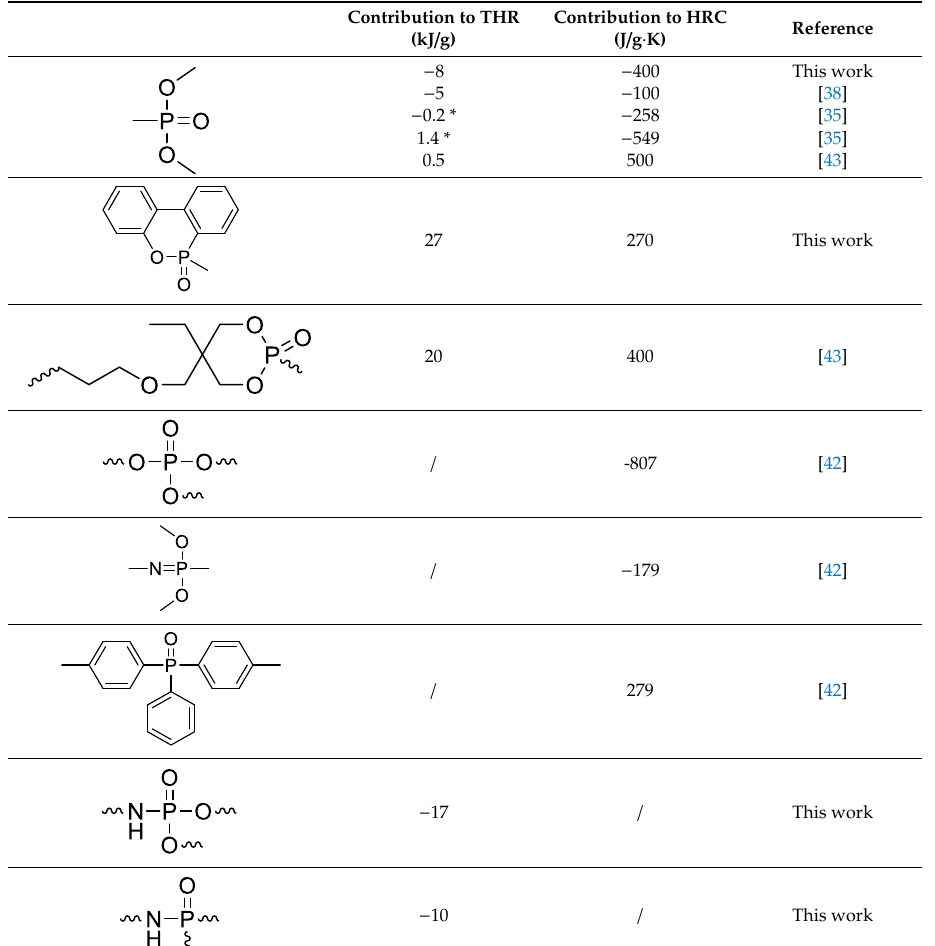
Figure 10. Experimental HRC versus MAPC1 content for various polymers (from series B and C).